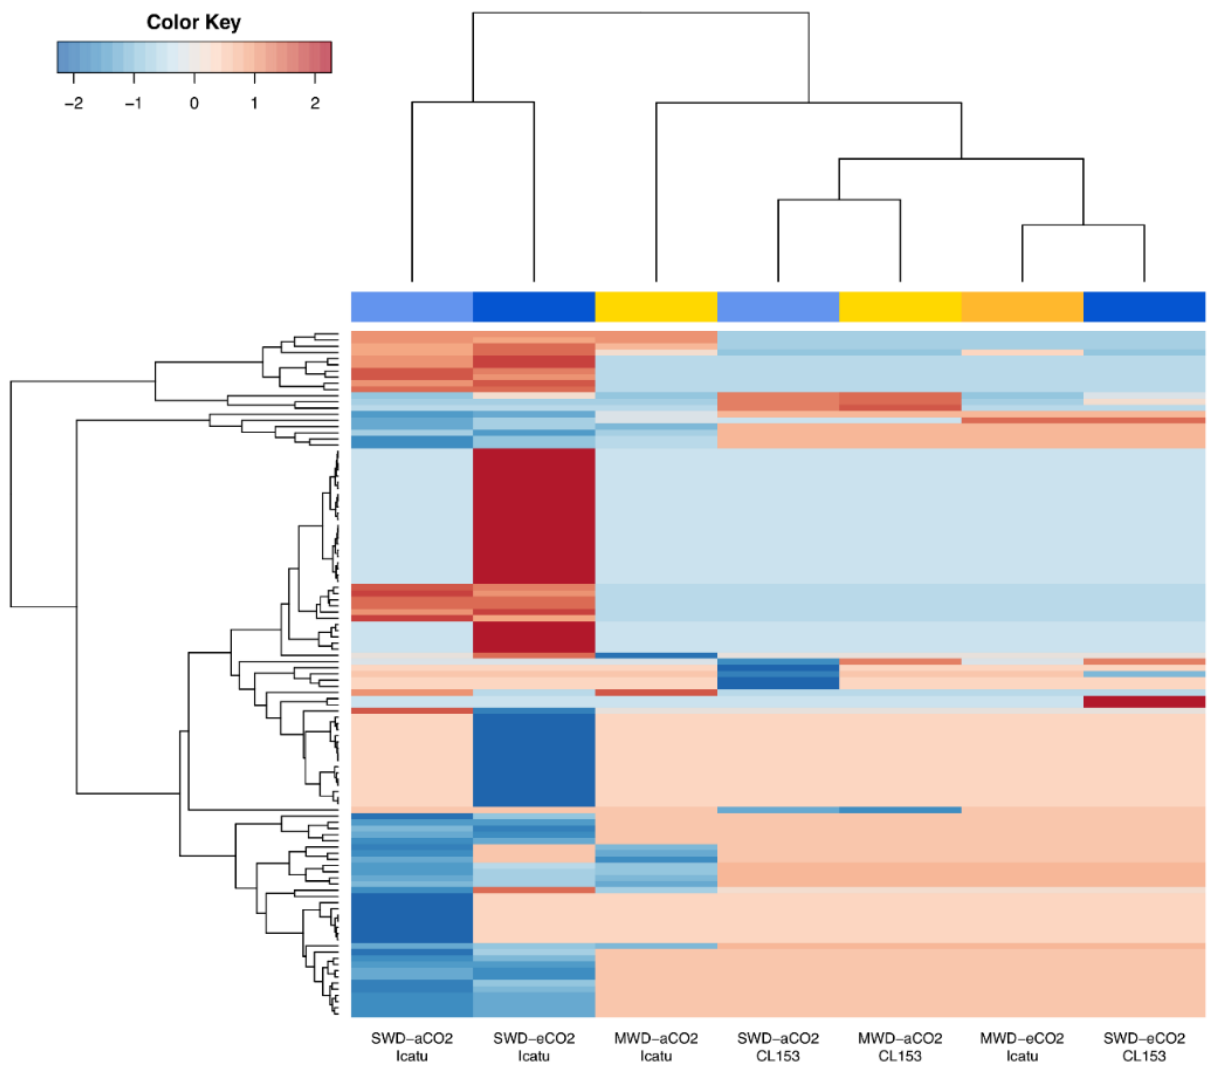
Figure 5. Clustered heatmaps and dendrograms of the normalized log 2 fold change (FC) visualizing the expression of drought-related DEGs in Icatu and CL153 plants grown under MWD or SWD in comparison with WW plants grown under aCO 2 or eCO 2 , at 25/20 ◦ C (day/night). Values were scaled by row using Z-scores. Hot colors represent up-regulated DEGs, and cold colors represent down-regulated DEGs. Column color labels groups comparisons by water treatments (yellow/orange: MWD; light blue/dark blue: SWD; light colors represent aCO 2 ; dark colors represent eCO 2 ). An absence of data in CL153 plants under MWD-eCO 2 indicates the absence of significant DEGs. Icatu plants grown under MWD and aCO 2 showed the most down-regulation for the PLAT domain-containing protein 3-like (FC: − 7.32) and the most up-regulation